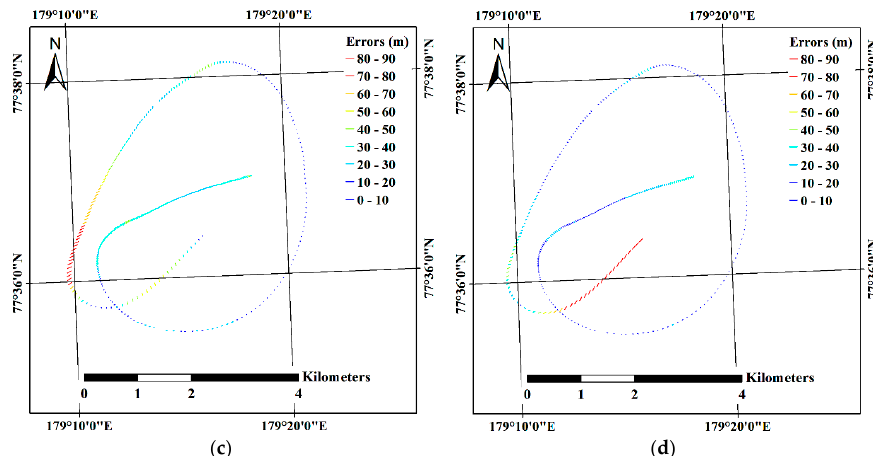
Figure 9. Quality assessment of the imaging locations during the mosaicking processes: ( a ) errors estimated from the imaging locations of Subset I before the sea ice drift compensation; and ( b ) after the sea ice drift compensation; and ( c ) errors estimated from the imaging locations of Subset II before the sea ice drift compensation; and ( d ) after the sea ice drift compensation. Table 5. Quality assessment using the imaging locations before and after the sea ice drift compensation. Image